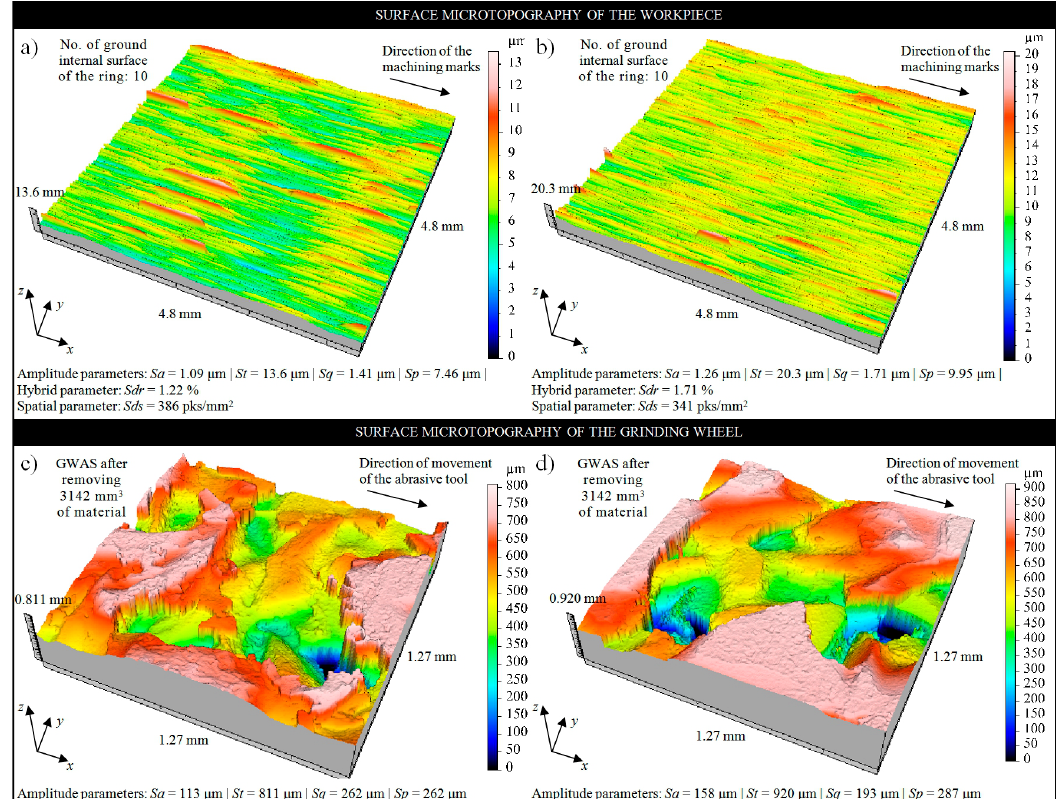
Figure 6. Collection of example results of measurements obtained after the grinding process of the rings made of INCONEL ® alloy 600 using 3D laser microscope Olympus LEXT OLS4000: microtopographies of internal surface of the ring No. 10 machined by: ( a ) STGW; ( b ) RGW; microtopographies of the active surface of: ( c ) STGW; ( d ) RGW; after ground of ten workpieces.